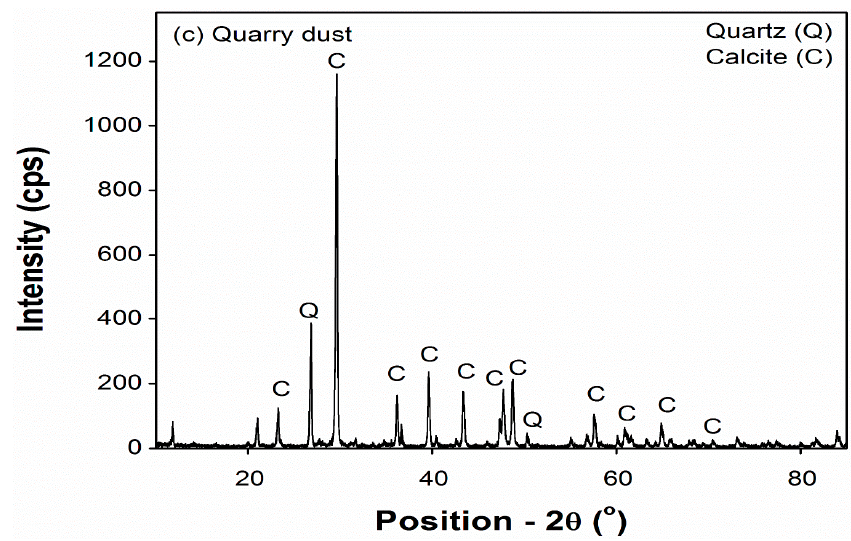
Figure 4. X-ray diffraction (XRD) analysis of the waste sand used in the study.